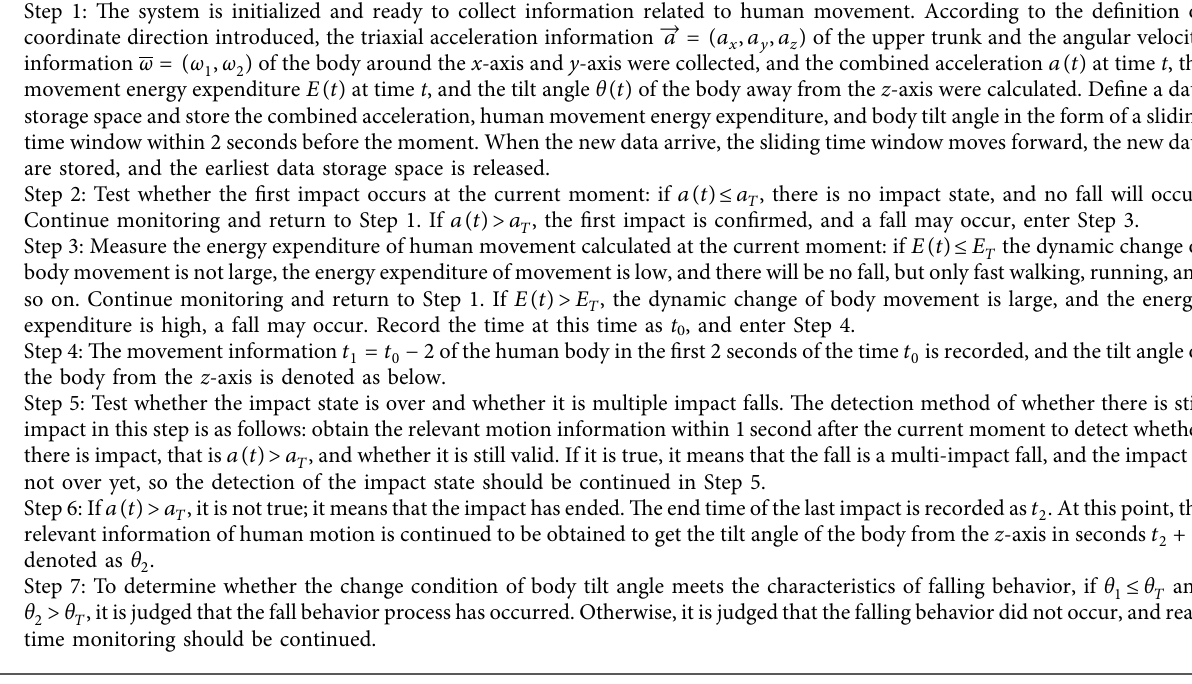
on Algorithm 1. In the algorithm, the threshold E T of combined acceleration, the threshold of movement energy expenditure, and the threshold θ T of body tilt angle from z - axis are, respectively, θ T � 41.36 °